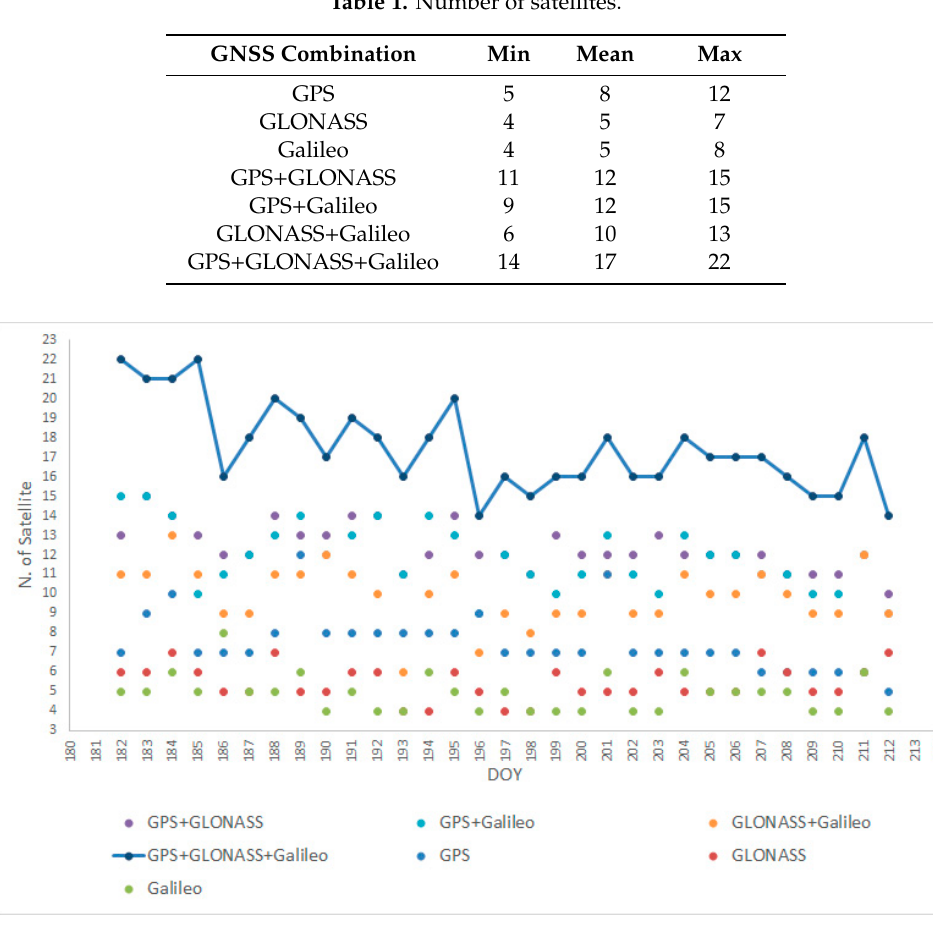
Figure 7. Number of maximum available satellites for each day of the dataset and for each Global Navigation Satellite System (GNSS) combination. DOY: Day of Year; GPS: Global Positioning System.